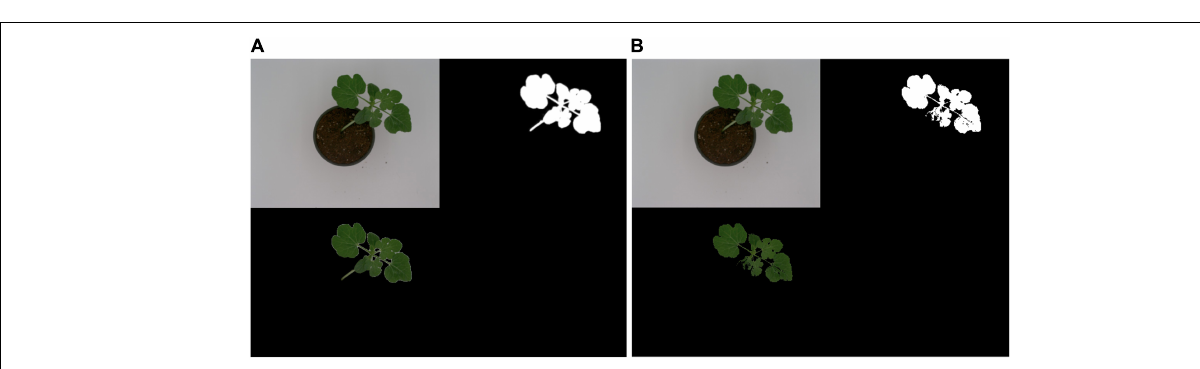
FIGURE 4 | Watermelon plant images captured using the data collection setup.